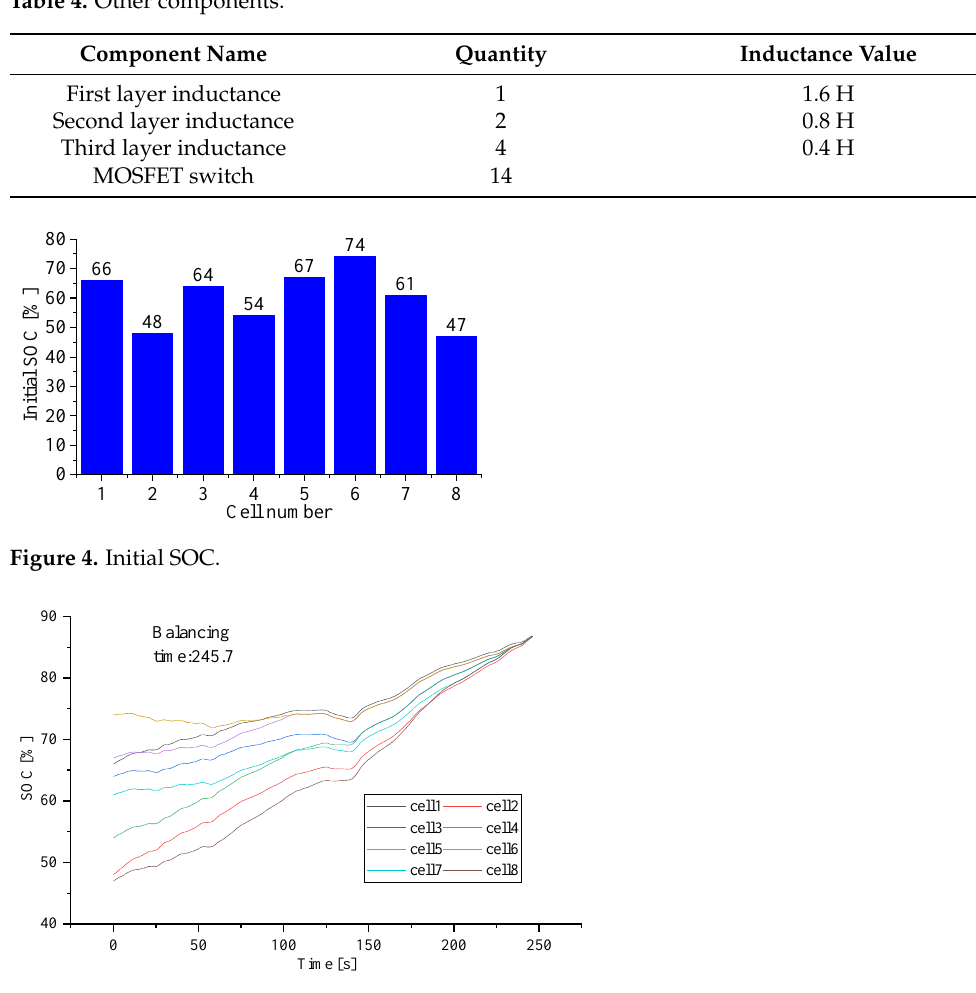
Figure 5. Lithium battery SOC change chart. (Multi-layer equalisation circuit without equalisation strategy)